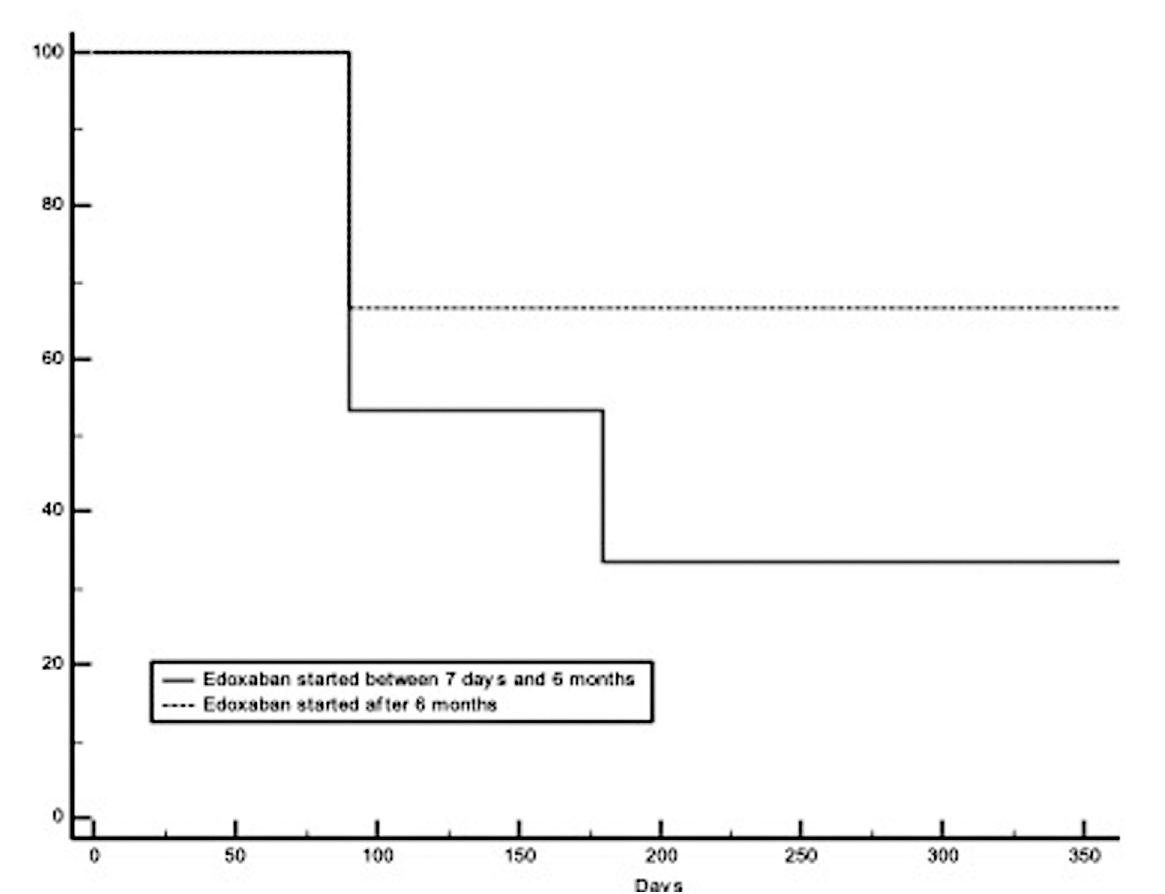
Fig. 1 Twelve-month survival curves of patients treated with edoxaban between 7 days and 6 months and those treated with edoxaban after 6 months from cancer-associated VTE. VTE, venous thromboembolism.